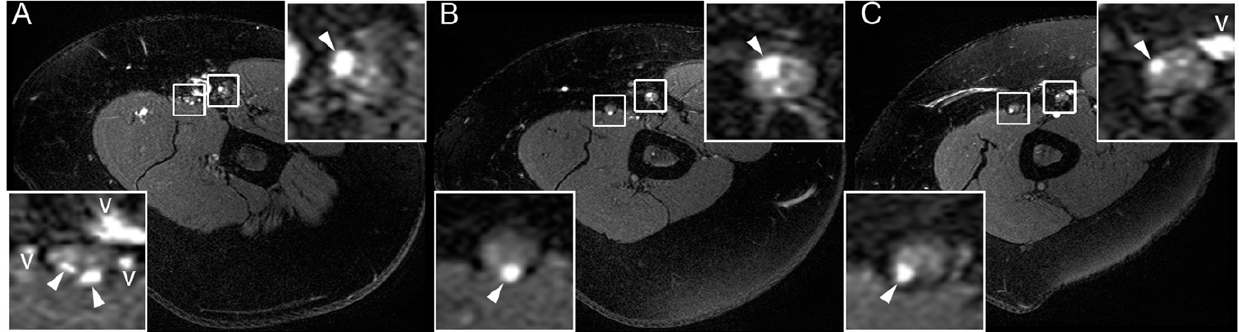
Figure 3. Continuous fascicular lesions. Lesions in one individual fascicle of both ulnar nerve and median nerve at upper arm level extending over a distance of at least 10 cm. [A] shows a T2-w proximal cross-section, [B] is at mid upper arm, [C] at a more distal position few cm above the elbow. Lower left magnifications show the ulnar nerve, upper right magnifications the median nerve. Fascicular nerve lesions (arrowheads) appear within the nerve, concomitant vessels (v) are adjacent to the nerve.